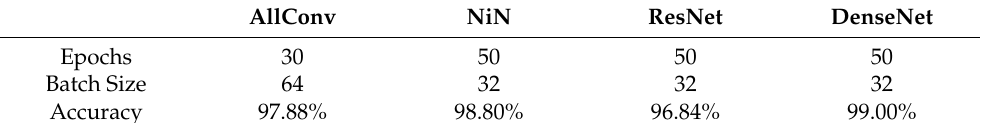
Table 1. The optimal hyper-parameter setting and predicting performance of the four networks for CV-QKD attack detection. Epochs refer to the turn number of iterate over the dataset. Batch Size refers to the number of data we used in one iteration. AllConv: all convolution network. NiN: Network in Network.